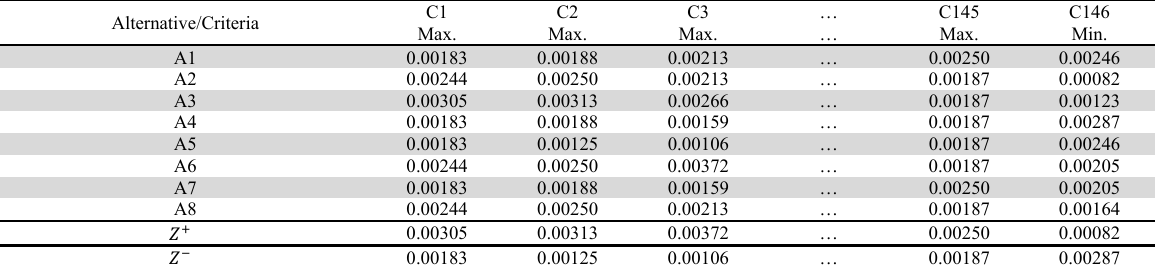
Weighted normalized decision-making matrix Alternative/Criteria